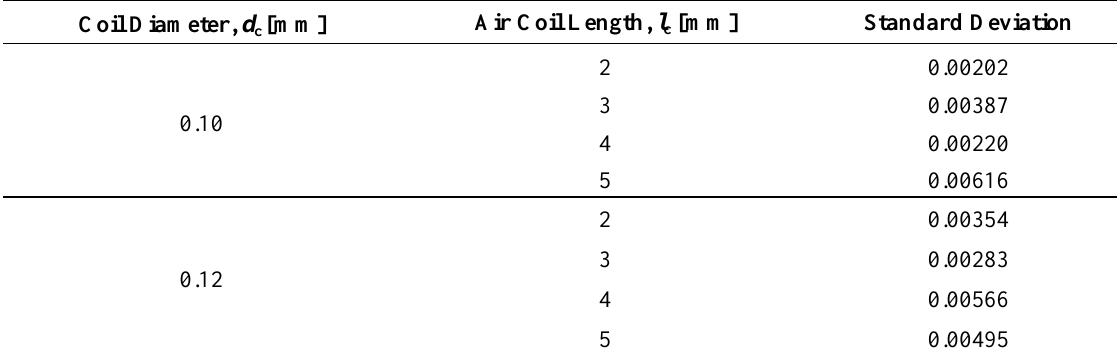
Table 4. The deviation between ripe to unripe samples for 5 mm air coil length. Coil diameter, d [mm] c The deviation between ripe to unripe samples Table 5. The standard deviation value for all types of sensors calculated using ANOVA. Coil Diameter, d c